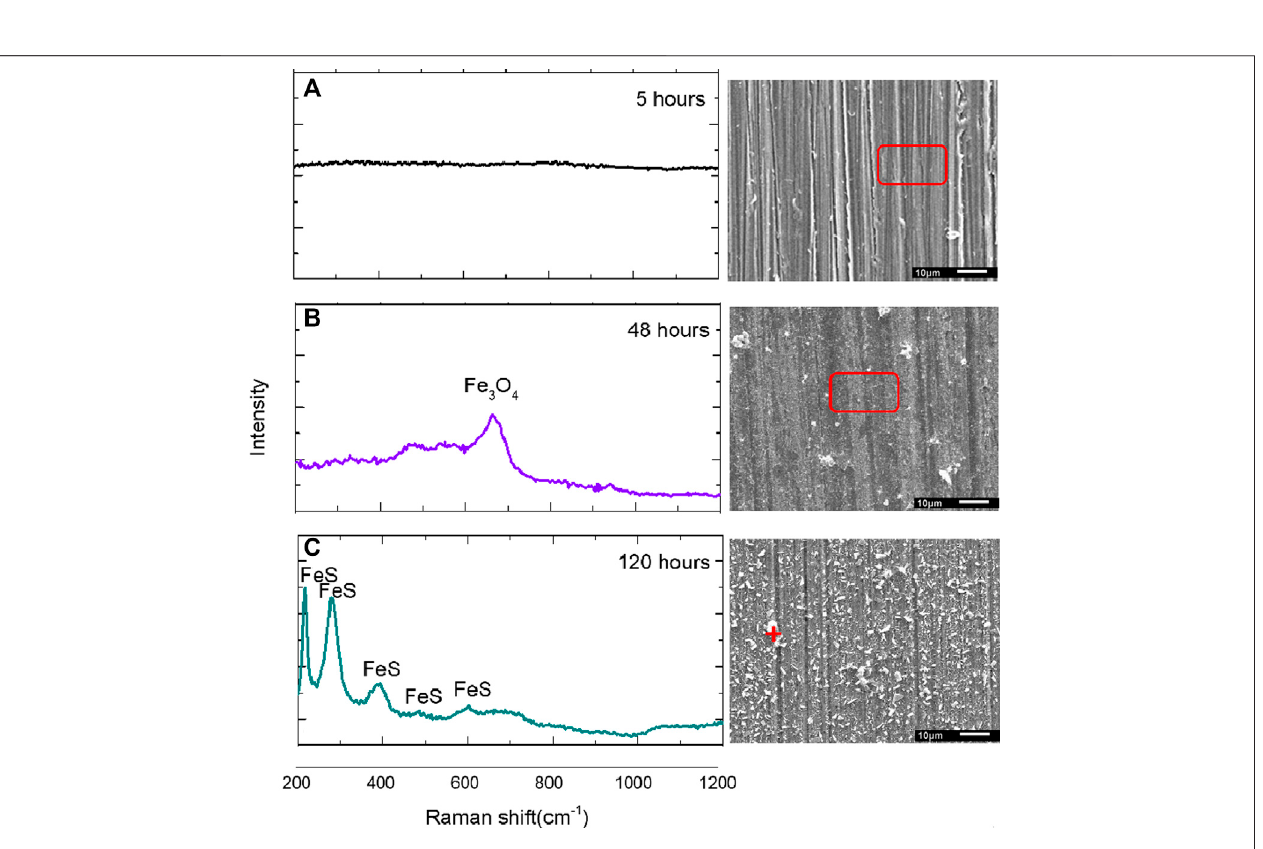
Frontiers in Materials |